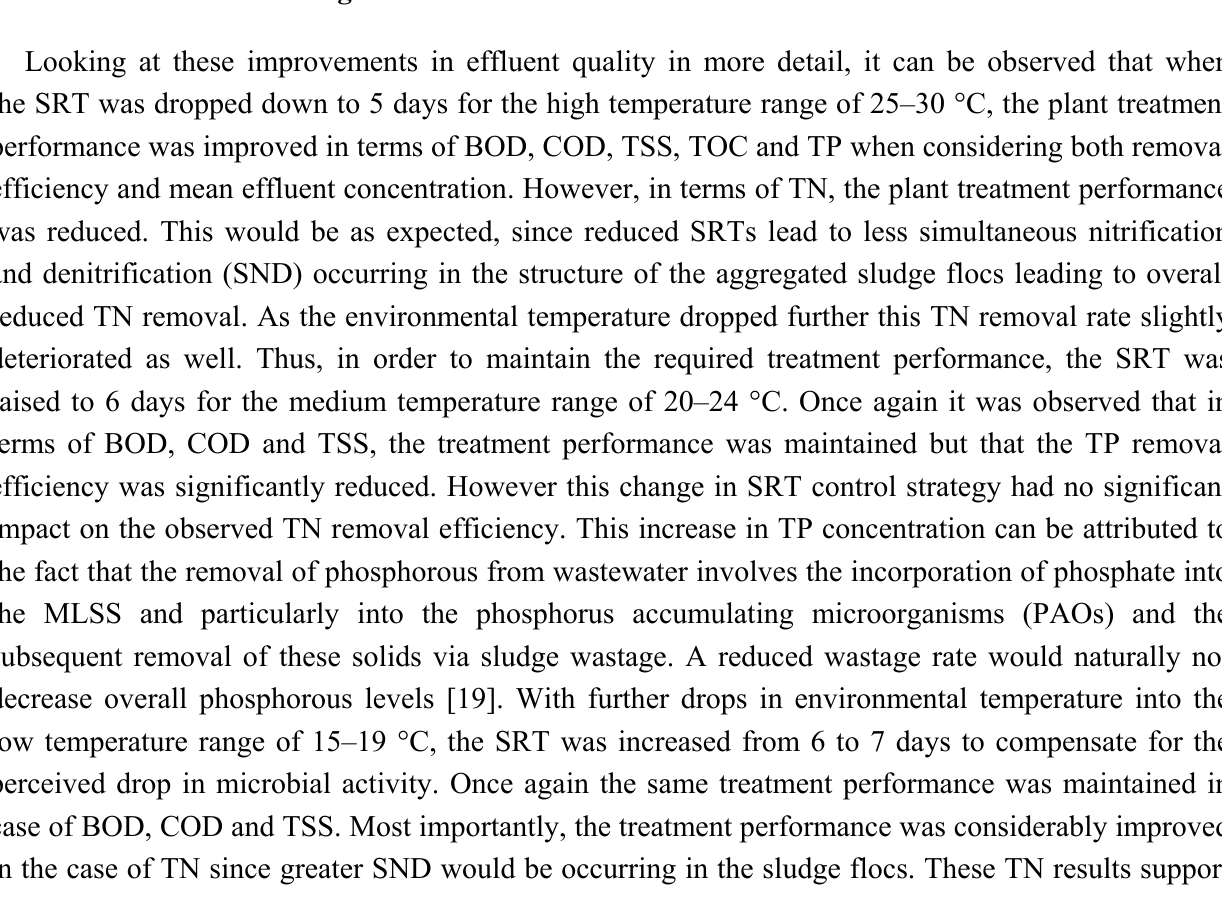
Figure 3. Removal efficiencies at different